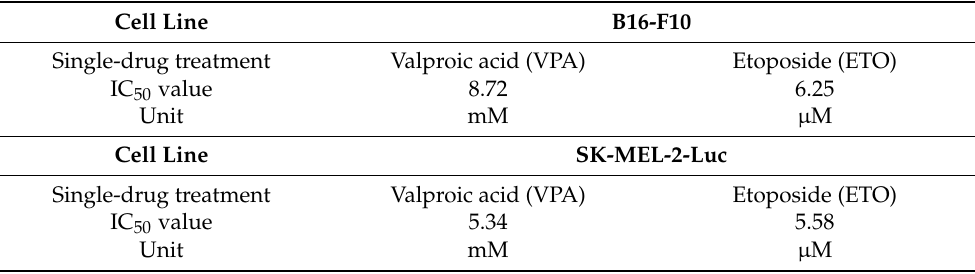
Figure 1. Dose-response analysis of VPA or ETO single treatment on melanoma B16-F10 and SK-MEL-2-Luc cells. The relative cell viability of B16-F10 cells was evaluated through cell viability assay after 72 h of single-drug treatments with either ( a ) VPA or ( b ) ETO. The relative cell viability of SK-MEL-2-Luc cells was evaluated likewise in response to ( c ) VPA or ( d ) ETO. The data are shown as means ± standard error of the mean (SEM) of independent experiments in triplicate. Table 1. IC 50 values of valproic acid (VPA) or etoposide (ETO) single treatment on B16-F10 and SK-MEL-2-Luc